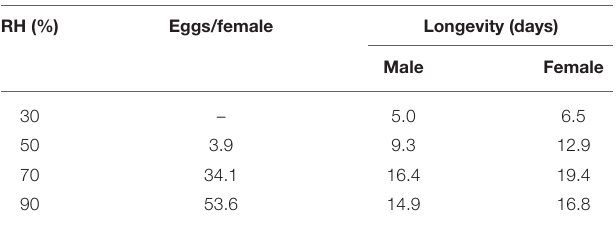
TABLE 1 | Effect of air relative humidity (RH) on the fecundity and longevity of Gymnandrosoma aurantianum (Tortricidae) (Garcia, 1998).